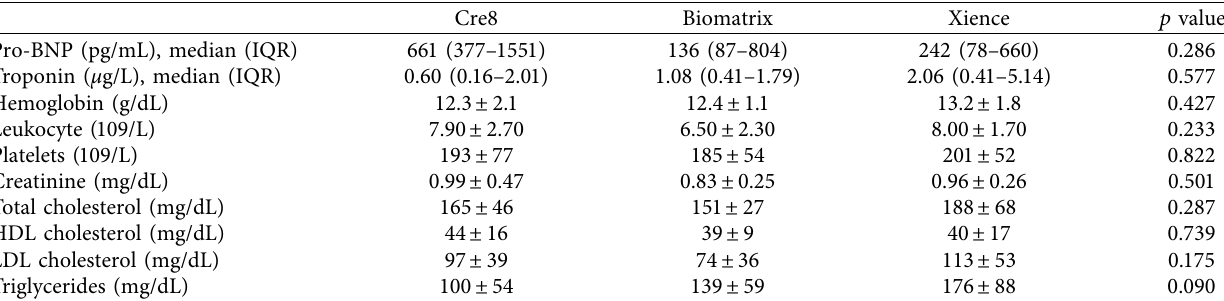
Table 2: Baseline biohumoral